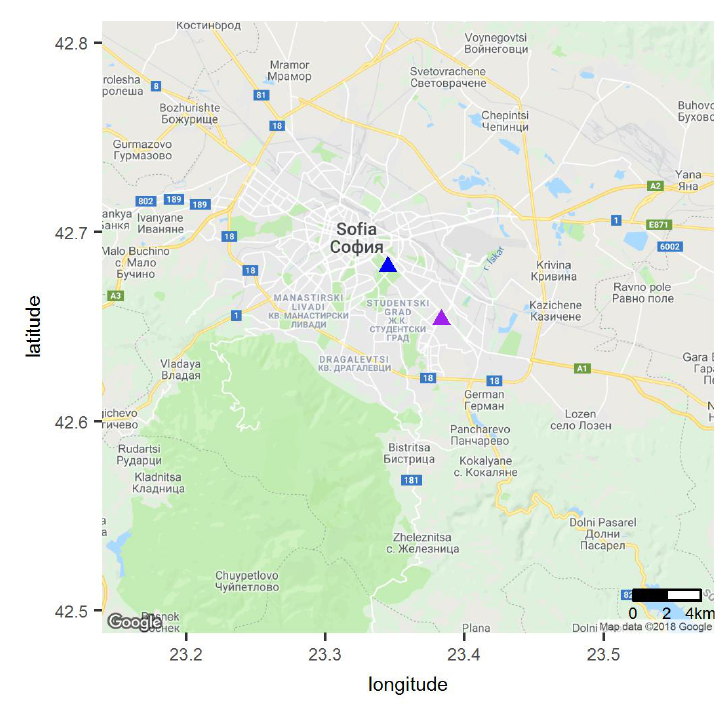
Figure 1. The locations of the ceilometer and the radiosonde indicated by a blue and a purple triangle in the Sofia valley. (Source of the map is Google